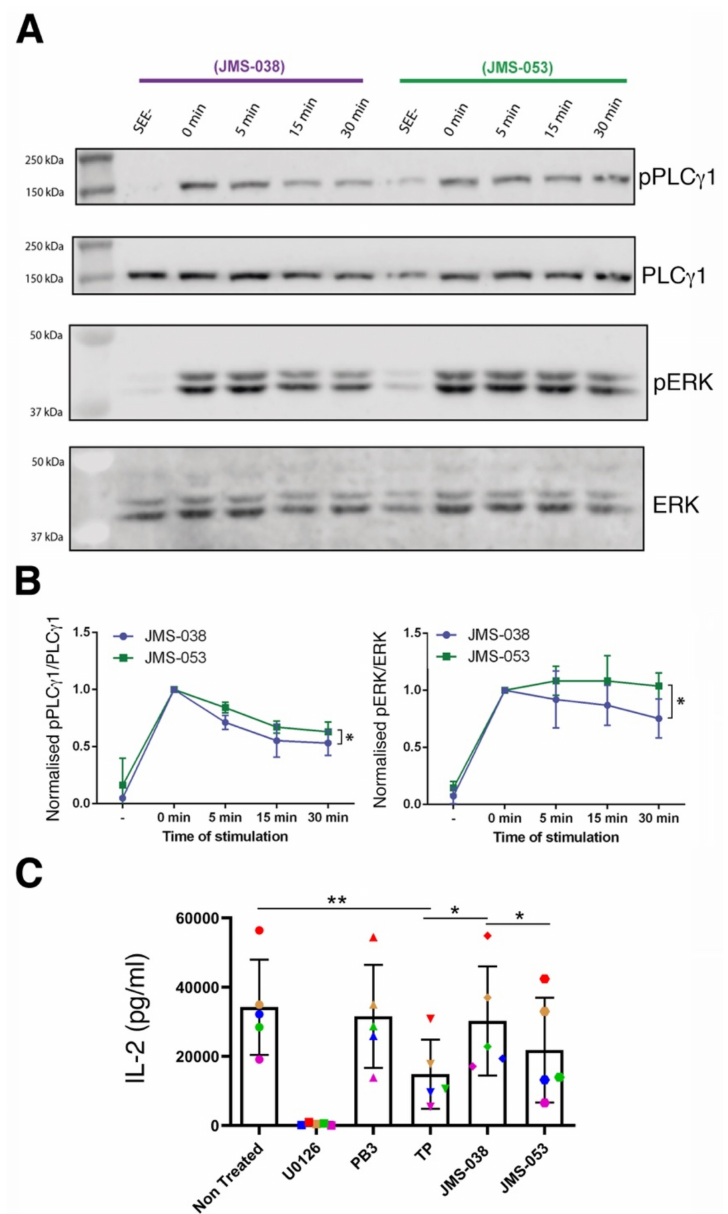
Figure 3. Regulatory role of the catalytic activity of PRLs during T cell activation. ( A ) Western blot of protein extracts of JK cells stimulated with SEE-loaded Raji cells for the indicated times in minutes (min). Samples of 0 min correspond to stimulation times at around the minute required to mix and spin-down cells before protein extraction. SEE- indicates the incubation of JK cells with Raji cells without SEE for the longest time used in stimulated samples. Molecules analyzed are indicated. ( B ) Phosphorylated fraction of the analyzed molecules in (A) normalized to the maximum. The mean +/ − the standard deviation is shown ( n = 3 independent experiments). Samples were compared by a paired two-tailed Student’s t-test. * p < 0.05. ( C ) IL-2 production by JK cells treated with 20 µ M U0126, 25 µ M PB3, 20 µ M TP, 5 µ M JMS-038 or JMS-053 and stimulated over night with PMA / Io. The mean +/ − the standard deviation is shown ( n = 5 independent experiments). The results of individual experiments are also indicated color coded in the graph. Samples were compared by a one-way ANOVA with a Tukey’s multiple comparison test. * p < 0.05, ** p <